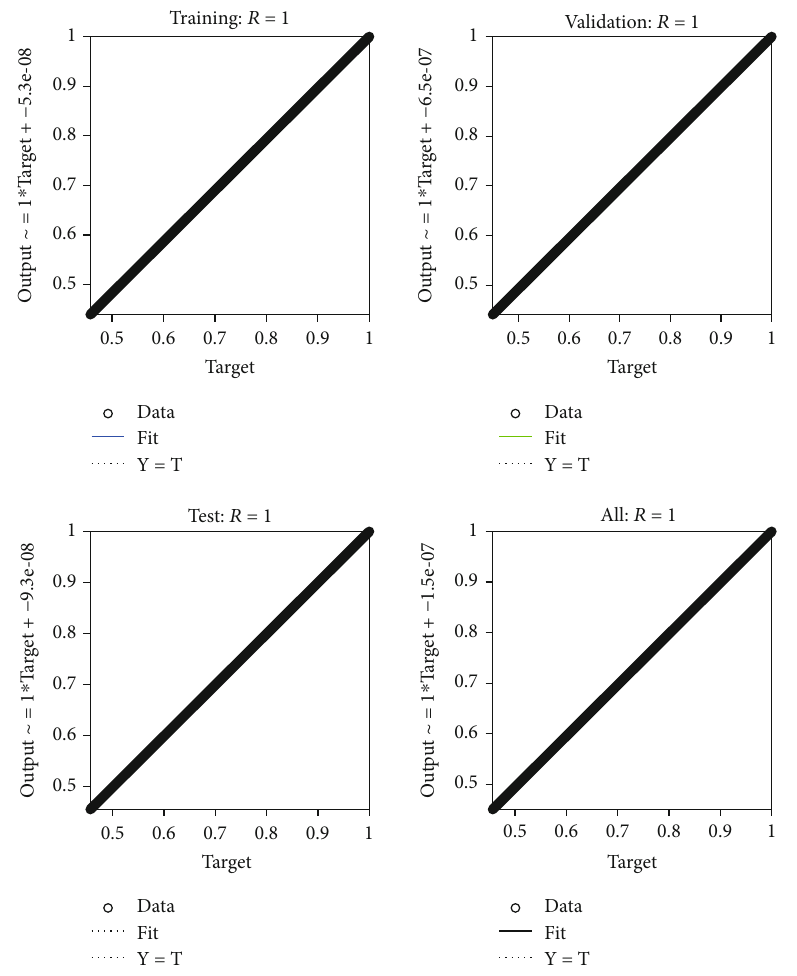
Figure 17: Training and validation of a DNN-wind MPPT controller. Table 2: DNN data of an MPPT controller for a wind